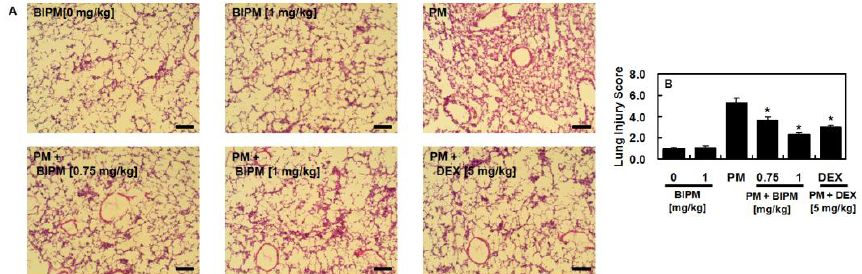
Figure 3. Chemical structure of biapenem (BIPM). Effects of BIPM on PM 2.5 -induced lung histopathological changes. The BIPM and DEX groups were injected intravenously 30 min after being intratracheally challenged with PM 2.5 (10 mg / kg in 50 µ L of saline). The mice were then sacrificed 24 h post-PM 2.5 -injection, and the lung tissue was harvested. ( A ) Lung histology was examined using hematoxylin and eosin staining. Representative images from each group are shown (n = 5). Scale bar: 200 µ m. ( B ) Lung injury score. The values represent the mean ± SD of three independent experiments. * p < 0.01 versus the PM-challenged group.